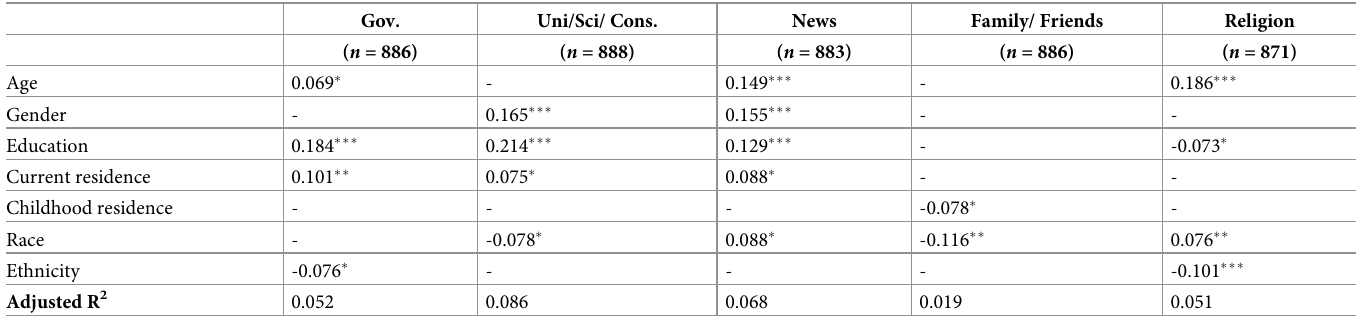
Table 8. Trust in sources for information on nature-related topics by demographics. Numbers represent standardized beta coefficients from stepwise regressions.